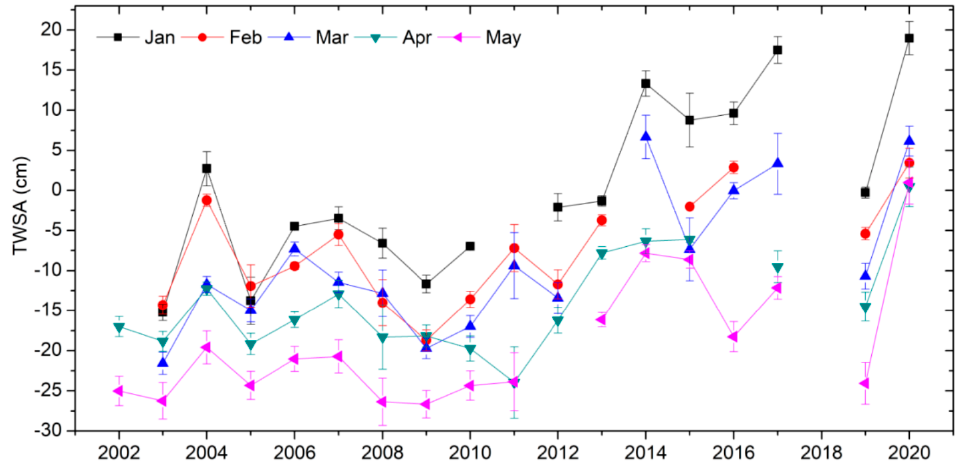
Figure 4. Monthly mean TWSA in January to May during 2002–2020. Quarterly, in situ groundwater level data from the Central Groundwater Board (CGWB) in this region show a general long-term increase during 2003–2017 (Figure 5). three out of four observations per year. The data show an increasing groundwater level trend in 233 out of 347 observation wells (Figure 5a). Mean quarterly groundwater levels show increasing values (Figure 5b) at rates of 3.31 cm/yr.